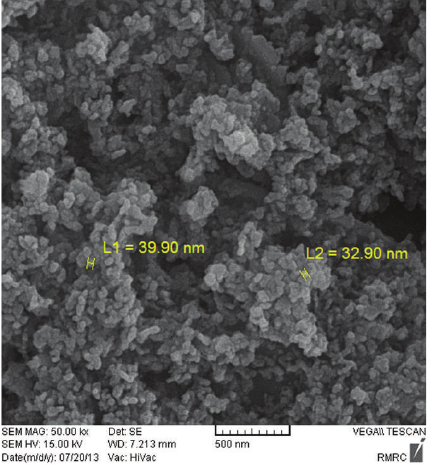
Figure 1: SEM photo of 1% Cu-doped ZnO nanocrystalline powder.